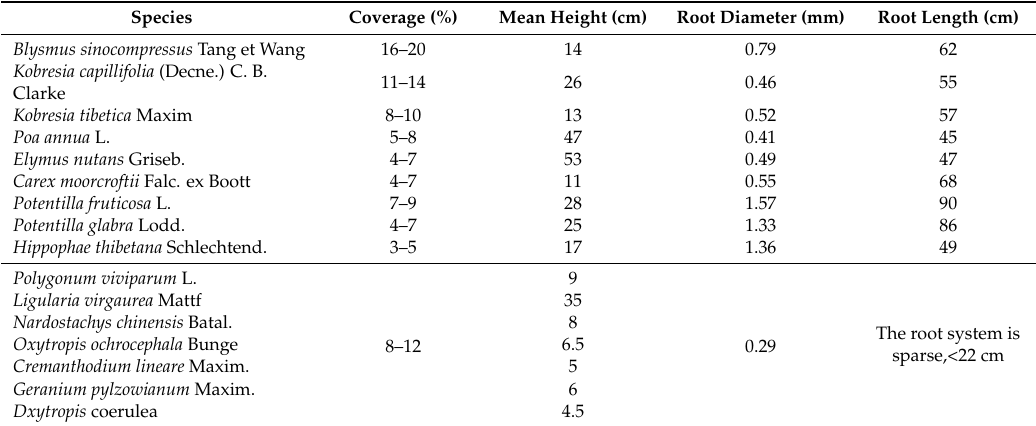
Table 1. Characteristics of aboveground riparian vegetation in the outer